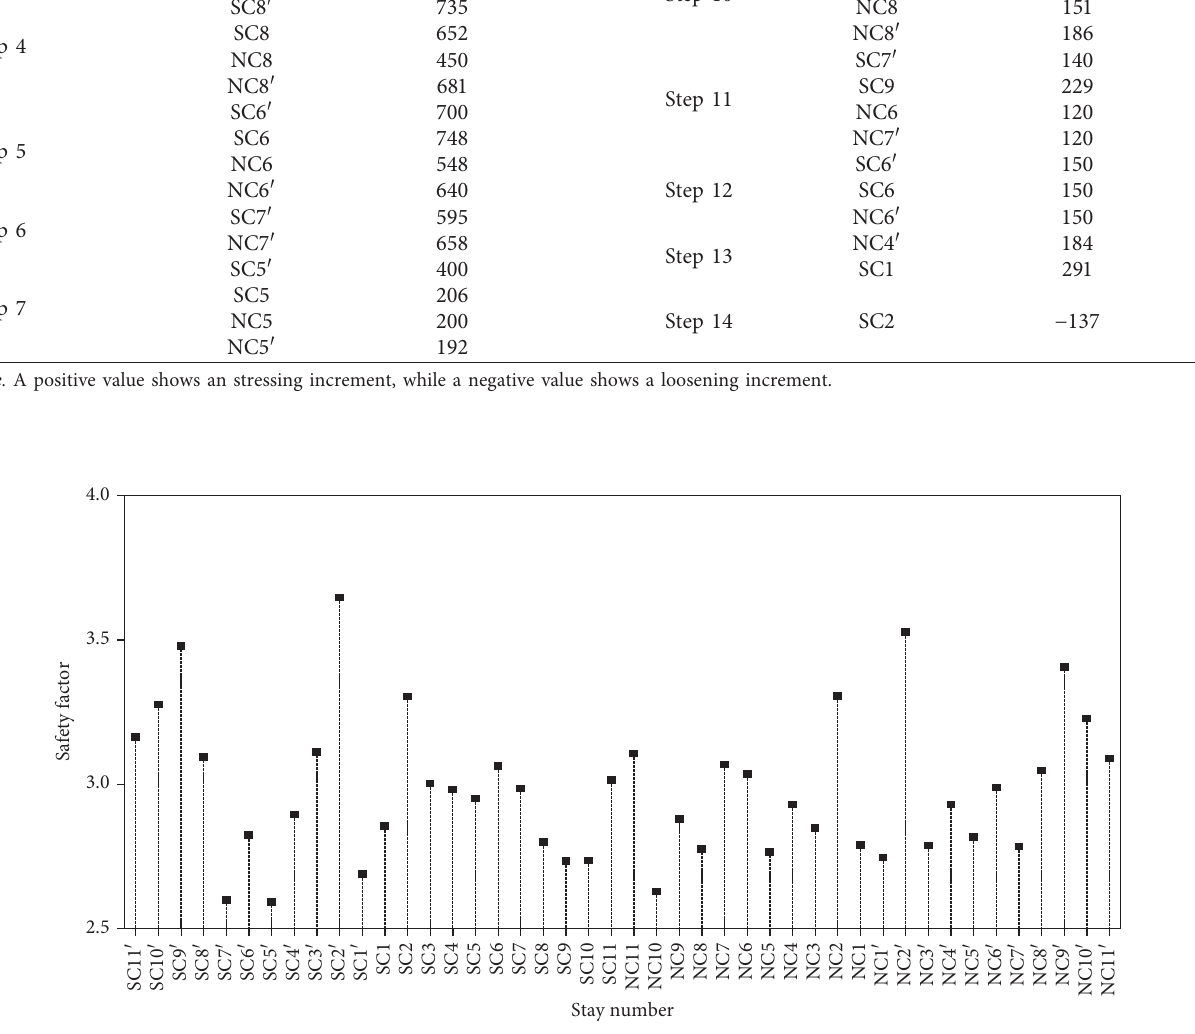
Figure 13: Safety factors in completed structure after cable